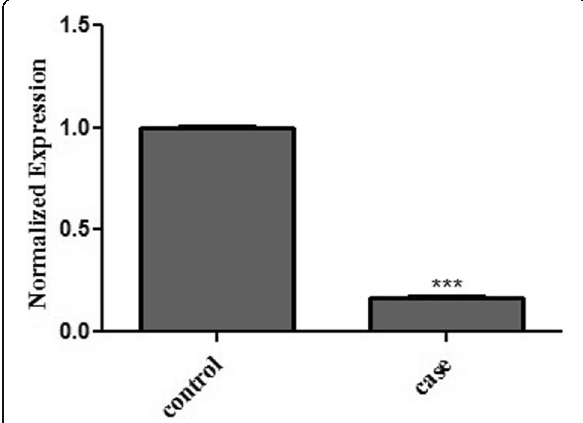
Fig. 3 Quantitative Real-Time PCR analysis of DPYS expression in patients liver tissue and a healthy tissue as control. The mRNA expression level of DPYS showed a significant decrease in patients liver tissue compared to the